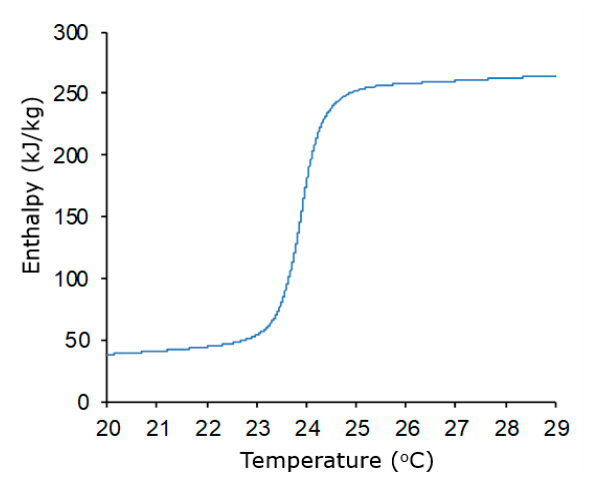
Figure 5. Enthalpy–temperature curve for PT24.